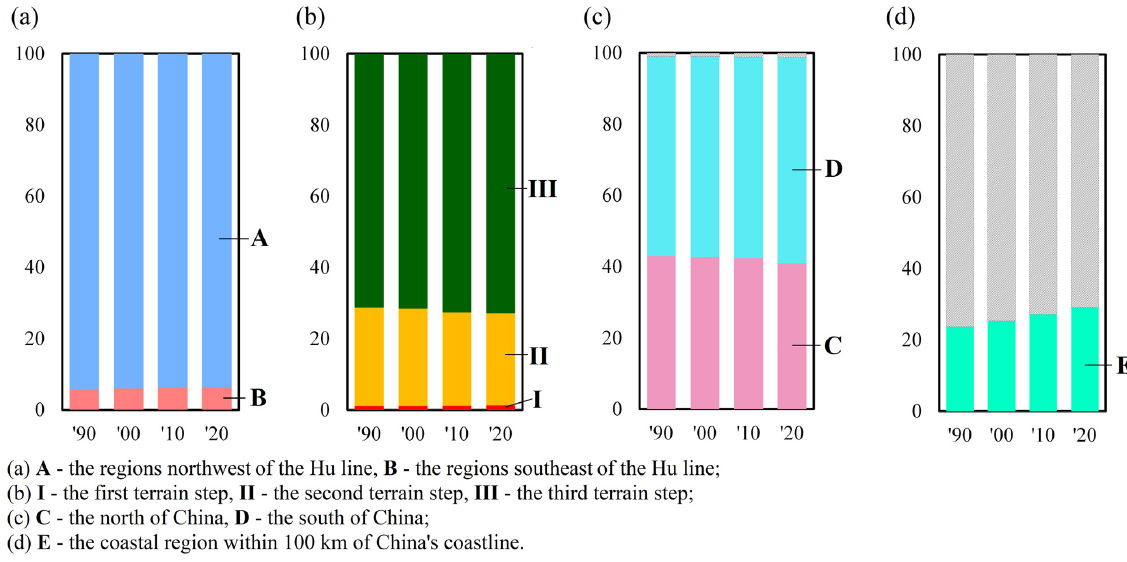
Figure 7. Population shares of each region in the national total. The sector rings A–E and I–III represent the regions in Figure 5 with the same notation.